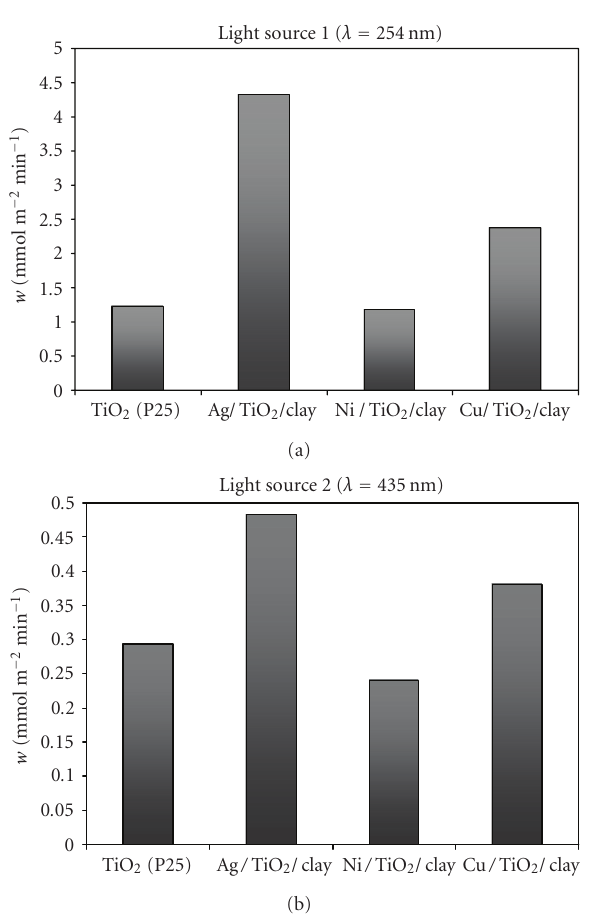
Figure 7: Decreasing of the ethanol concentrations is normalized to 1 g of TiO 2 in unit time (10